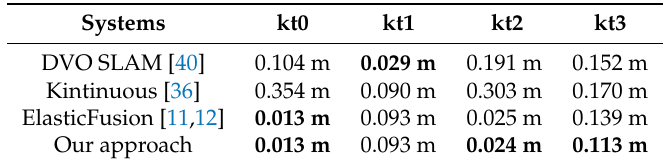
Table 3. Comparison of ATE RMSE on the ICL-NUIM synthetic datasets [50].